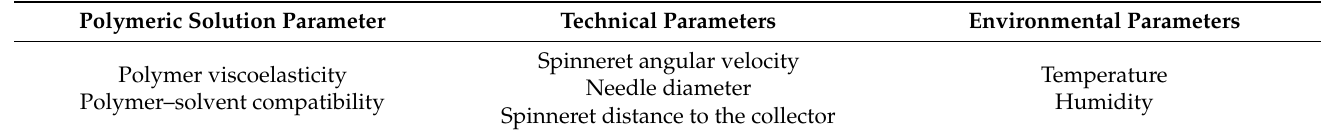
Table 1. Influence parameters in nanofiber characteristics in Forcespinning TM